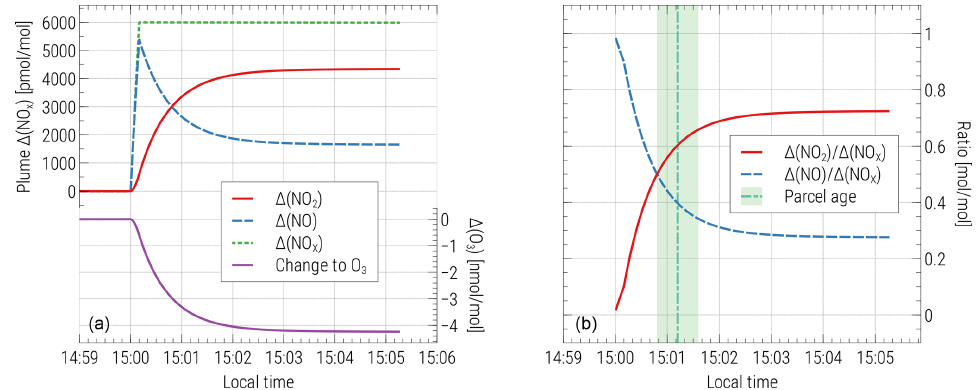
Figure C1. CAABA–MECCA box model simulation for the presented measurement day using representative environmental conditions. At 15:00 simulated local time, a 10s emission of NO into the box is performed, representing the emission from road traffic. Panel (a) shows changes in NO x =NO + NO 2 and ozone (O 3 ) compared to the background values. Panel (b) depicts the NO 2 -to-NO x as well as NO-to-NO x ratio in the